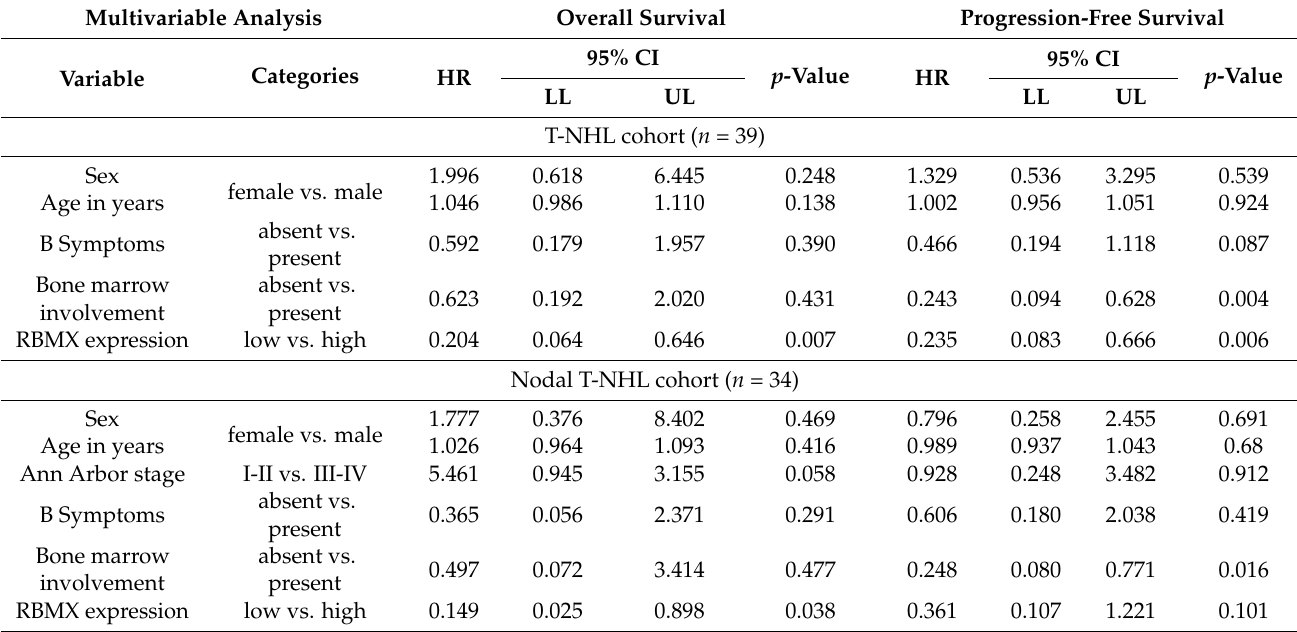
Table 3. Multivariable analysis of overall survival (OS) and progression-free survival (PFS) in T-NHL and nodal T-NHL. Multivariable Analysis Overall Survival Progression-Free Survival Variable